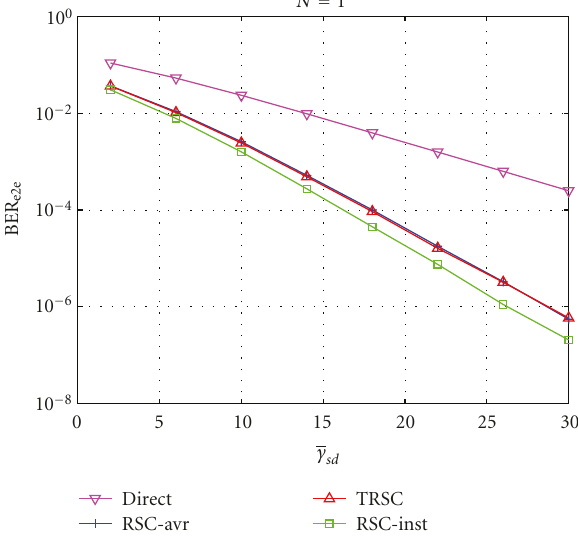
Figure 5: The e2e BER for all relaying protocols for N = 1 relay under random topologies.